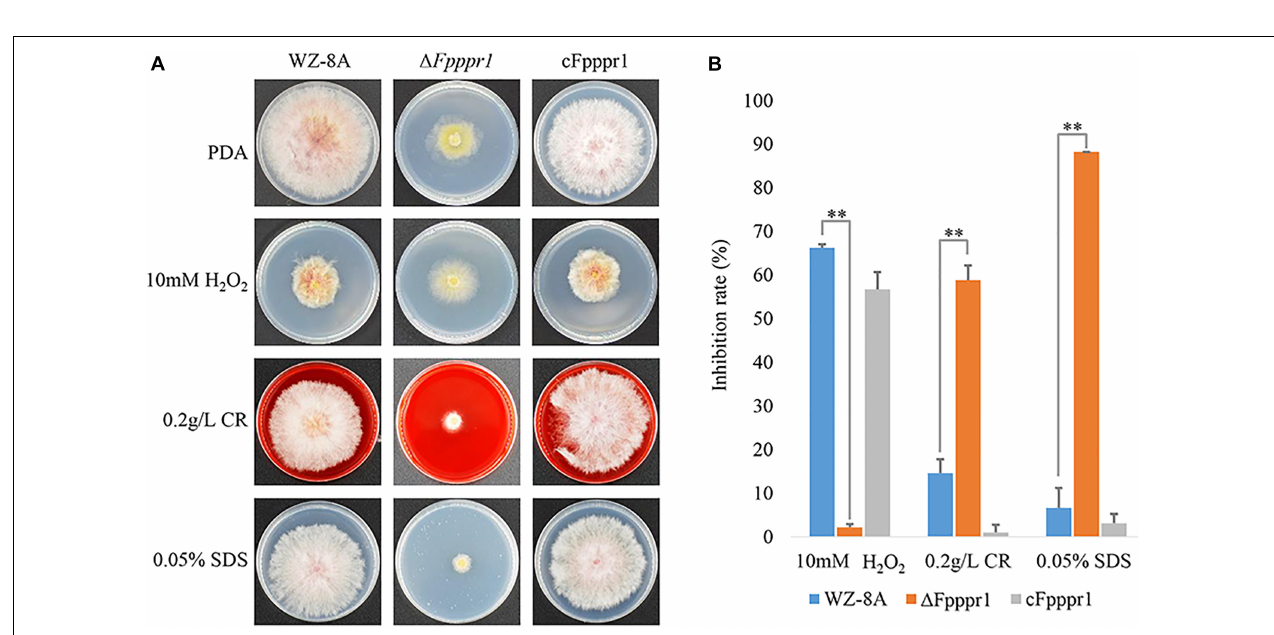
FIGURE 5 | Evaluation of responses to various stresses H 2 O 2 , Congo red, and SDS. (A) Colonies of wild type WZ-8A, (cid:49) Fpppr1 mutant, and complemented strain cFpppr1 on media with 10 mM H 2 O 2 , 0.2 g/L Congo red, or 0.05% (w/v) SDS. (B) Mycelial growth inhibition compared with non-treated controls following incubation for 3 days on PDA containing 10 mM H 2 O 2 , 0.2 g/L Congo red, or 0.05% (w/v) SDS ( ∗∗ p <